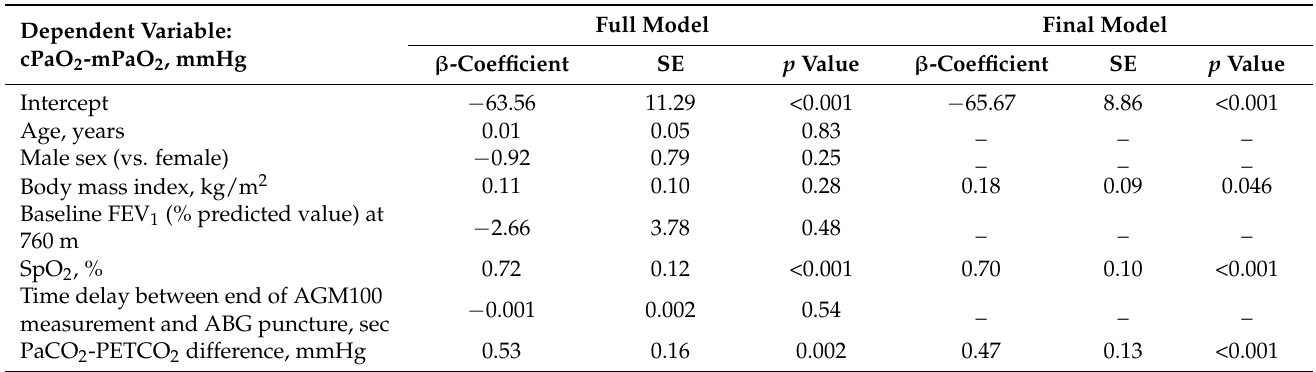
Table 3. Multivariable linear analysis of factors associated with the discrepancy between cPaO 2 and mPaO 2 .